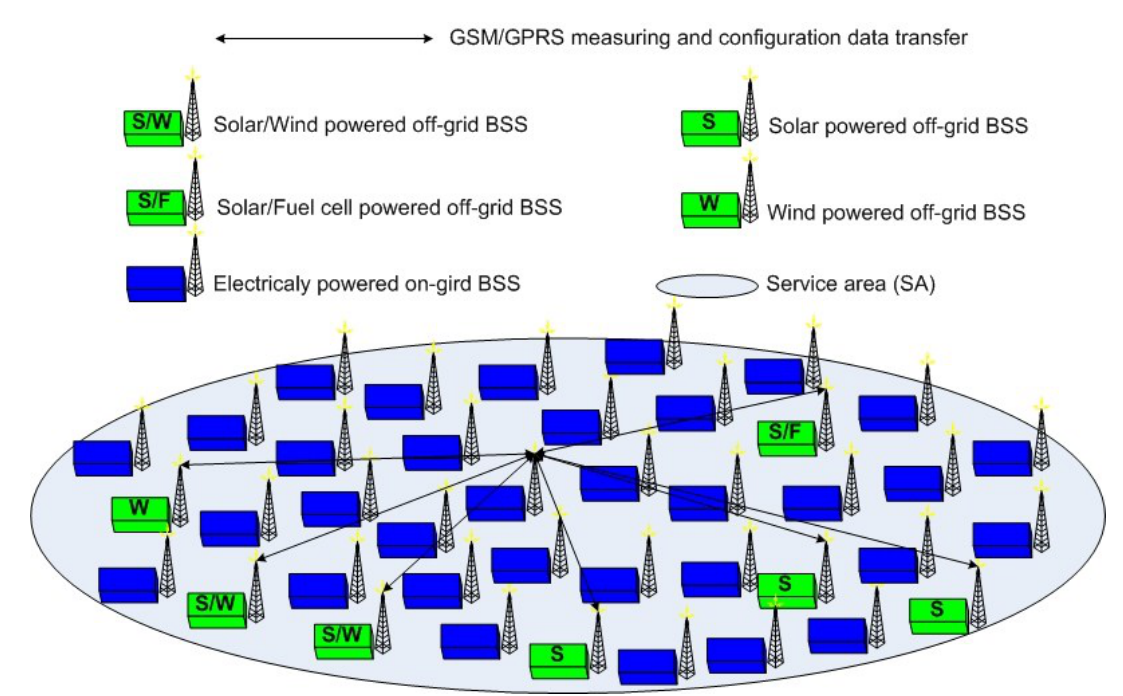
Figure 1. Allocation of on and off-grid base station sites (BSSs).